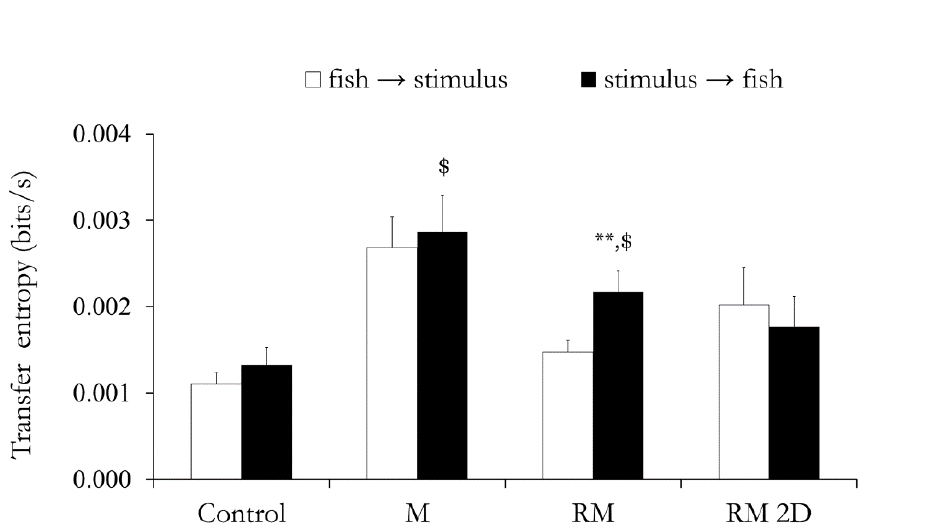
Figure 12. Transfer entropy for experiments on the interaction between live fish and an improved replica maneuvered by a robotic arm along three-dimensional pre-programmed trajectories. Experiments refer to four conditions, in which the replica was maneuvered along realistic three-dimensional trajectories (RM), the diving motion of the replica was abolished (RM2D), the replica was replaced by a transparent model moving along realistic three-dimensional trajectories (M), and neither a replica nor a transparent model were attached to the rod that was held fixed on the water surface. Error bars represent ± standard errors, asterisks indicate significant difference in transfer entropy from the stimulus to the fish and vice versa, and dollar symbol indicates a significant difference with respect to the Control condition. [Reproduced from (Ruberto et al.,